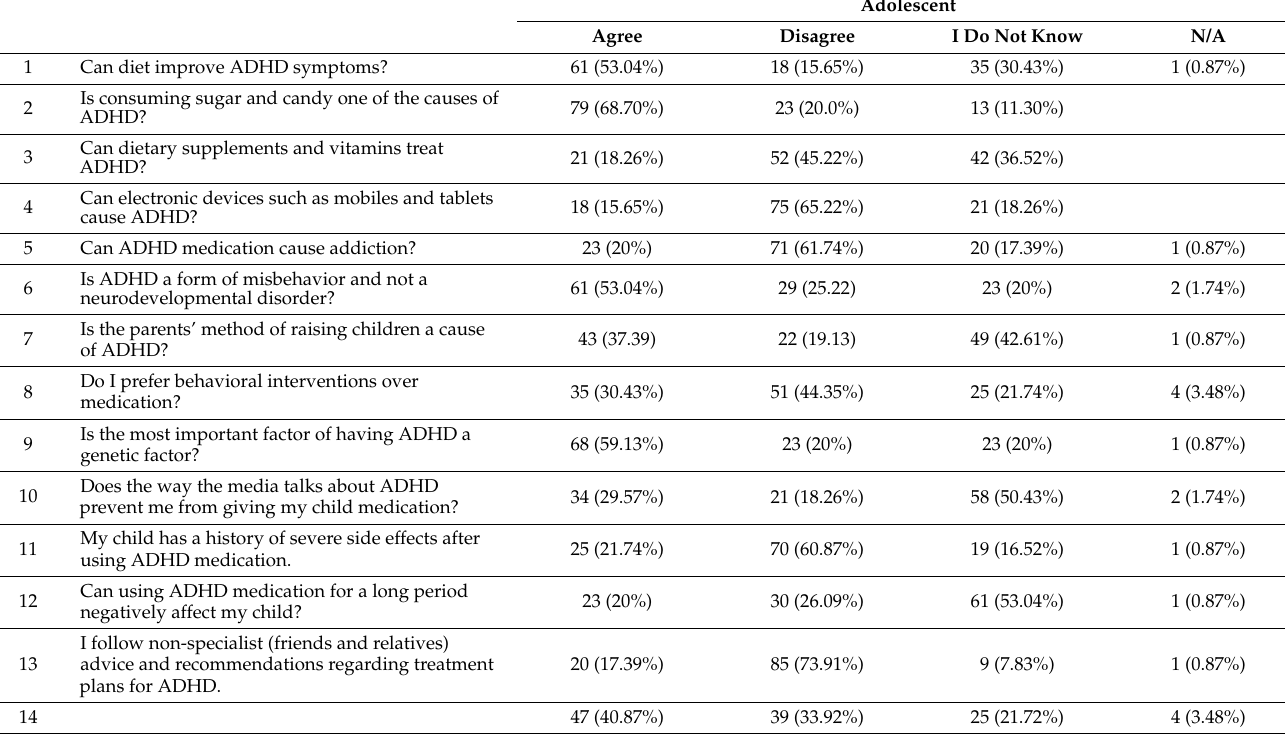
Table 4. Parental responses (adolescent